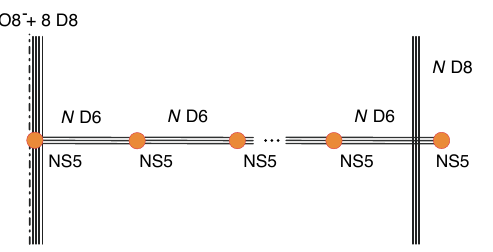
Figure 39 . 6d brane con(cid:12)guration for the quiver [1 A ; 8] (cid:0) SU( N ) (cid:0) SU( N ) (cid:0) (cid:1) (cid:1) (cid:1) (cid:0) SU( N ) (cid:0) [ N ] which has an antisymmetric hypermultiplet and eight fundamental (cid:13)avors of the leftmost gauge group of the quiver also coupled to tensor